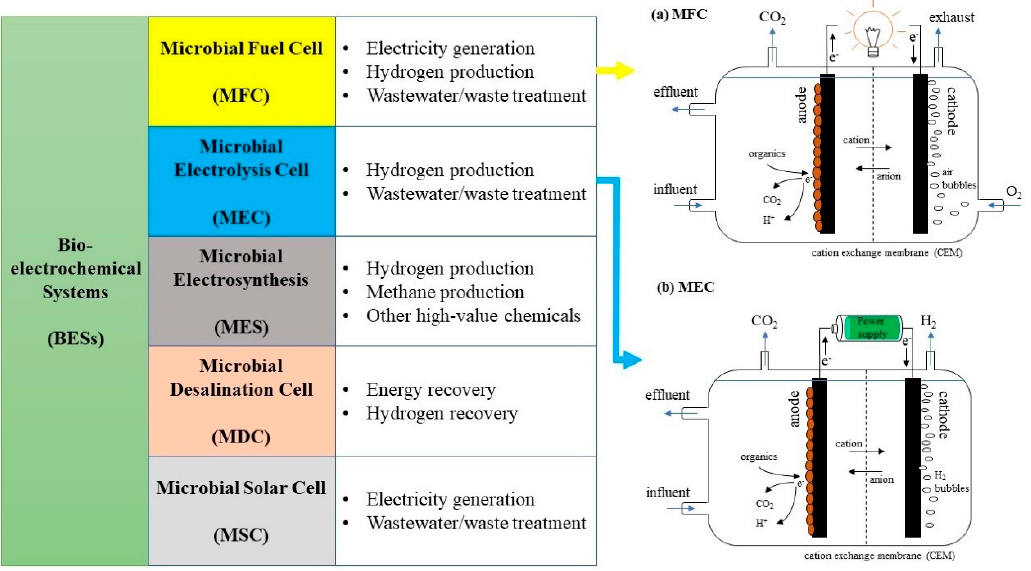
Figure 1. Overview of various types of bioelectrochemical systems (BESs), and schematics of the two most common BESs: ( a ) two-chamber microbial fuel cell (MFC); ( b ) two-chamber microbial electrolysis cell (MEC) for H 2 production.